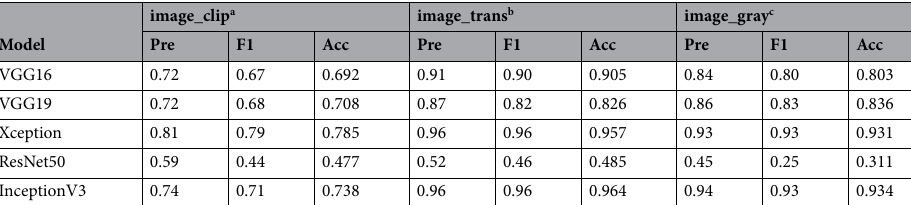
Table 6. Precision, F1 scores and accuracy of three pre-process methods. a image_clip, the clipped images. b image_trans, the transformed images. c image_gray, the transformed grayscale images.